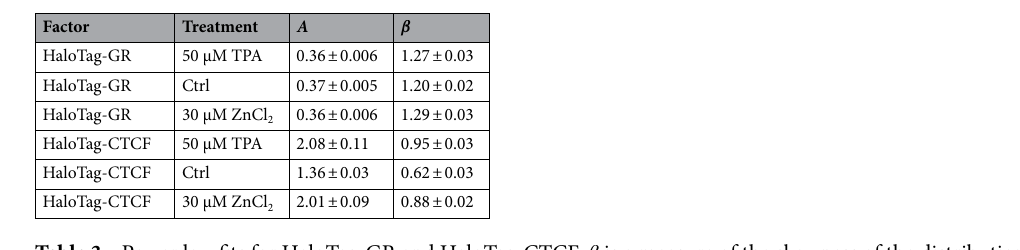
Table 3. Power law fits for HaloTag-GR and HaloTag-CTCF. β is a measure of the skewness of the distribution and is therefore proportional to dwell